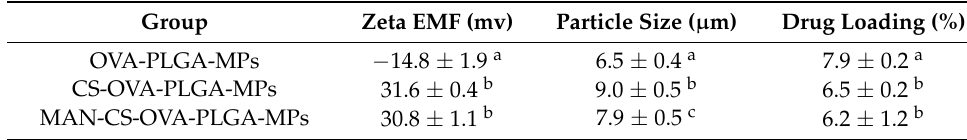
Table 4. Physical properties of three different types of PLGA microspheres.